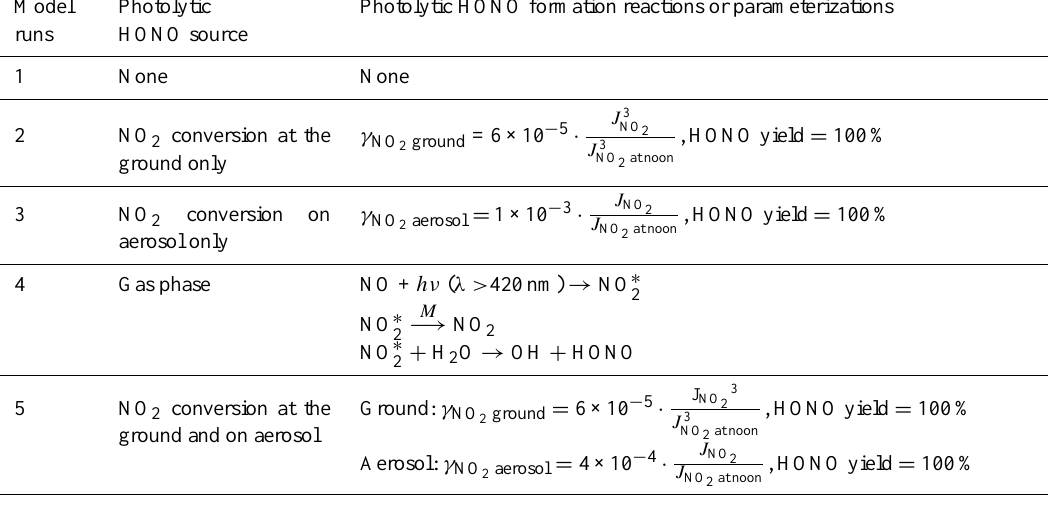
Table 1. Summary of different model runs. Model